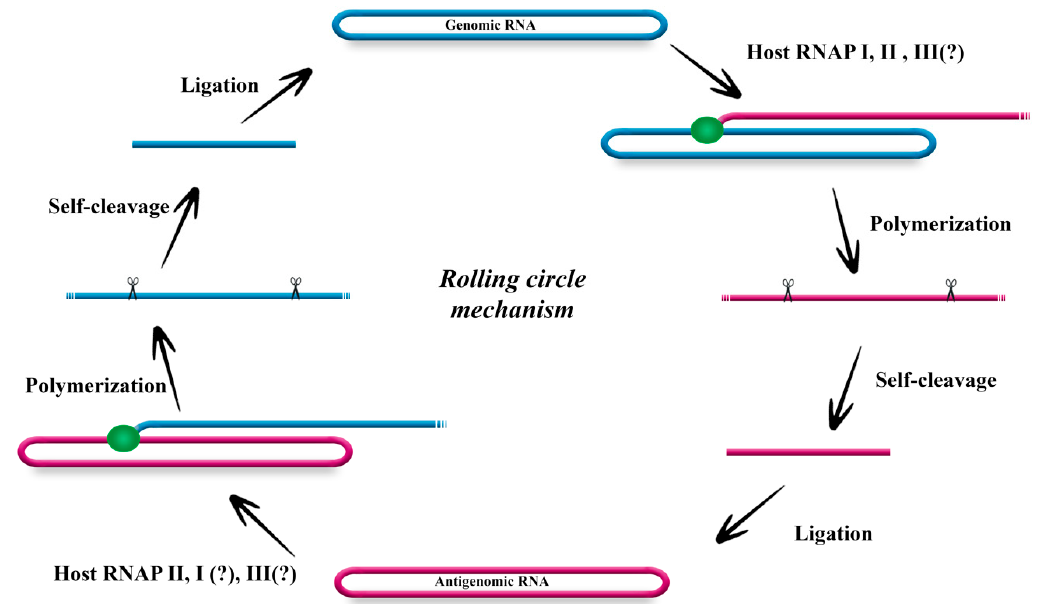
Figure 2. Hepatitis delta virus (HDV) replication model: symmetrical rolling circle. HDV genomic strand (blue) is used as a template to generate the antigenomic RNA using a host polymerase to generate a multimeric linear strand. This strand is self-cleaved by endogenous delta ribozymes (scissor symbols) and presumably ligated by a host enzyme to form the antigenomic monomeric strand (pink). The same steps are repeated on the antigenomic strands to produce a newly synthesized genomic strand. The genomic template is also used for the antigen mRNA synthesis. Question marks next to several RNAPs indicate that the involvement in HDV biology remains controversial.